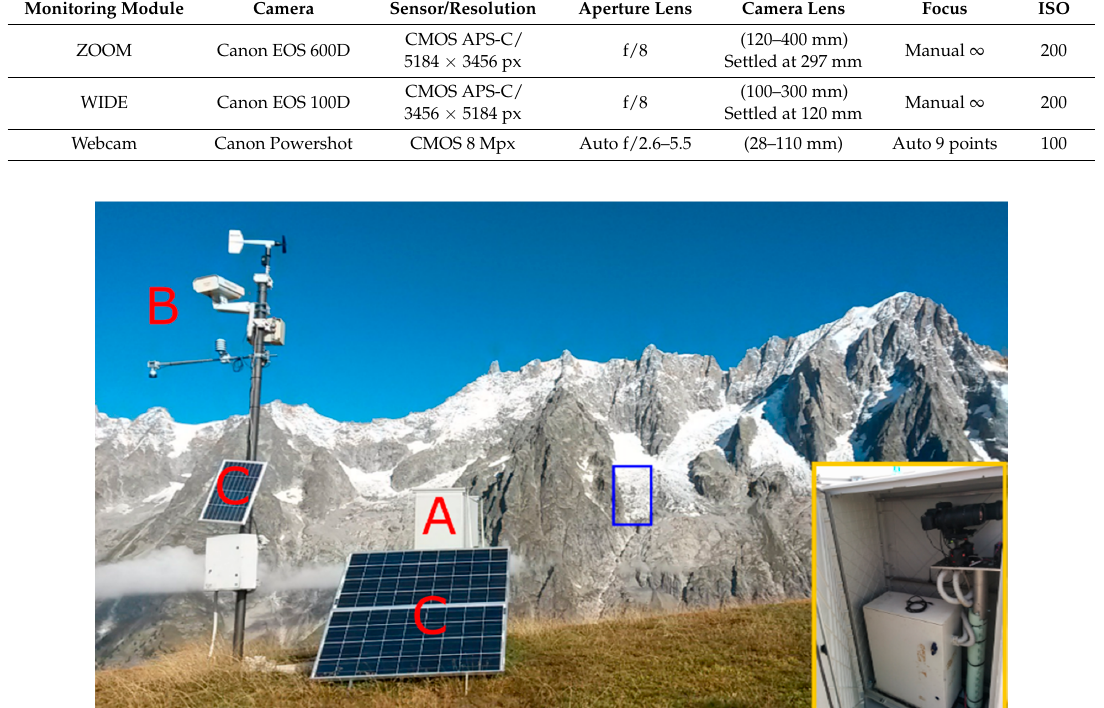
Figure 3. Monitoring station: (A) Box containing the two cameras. (B) Webcam and weather station. (C) Solar panels. The area acquired is highlighted in blue. In the yellow box: detail of the acquisition system within the shelter box.